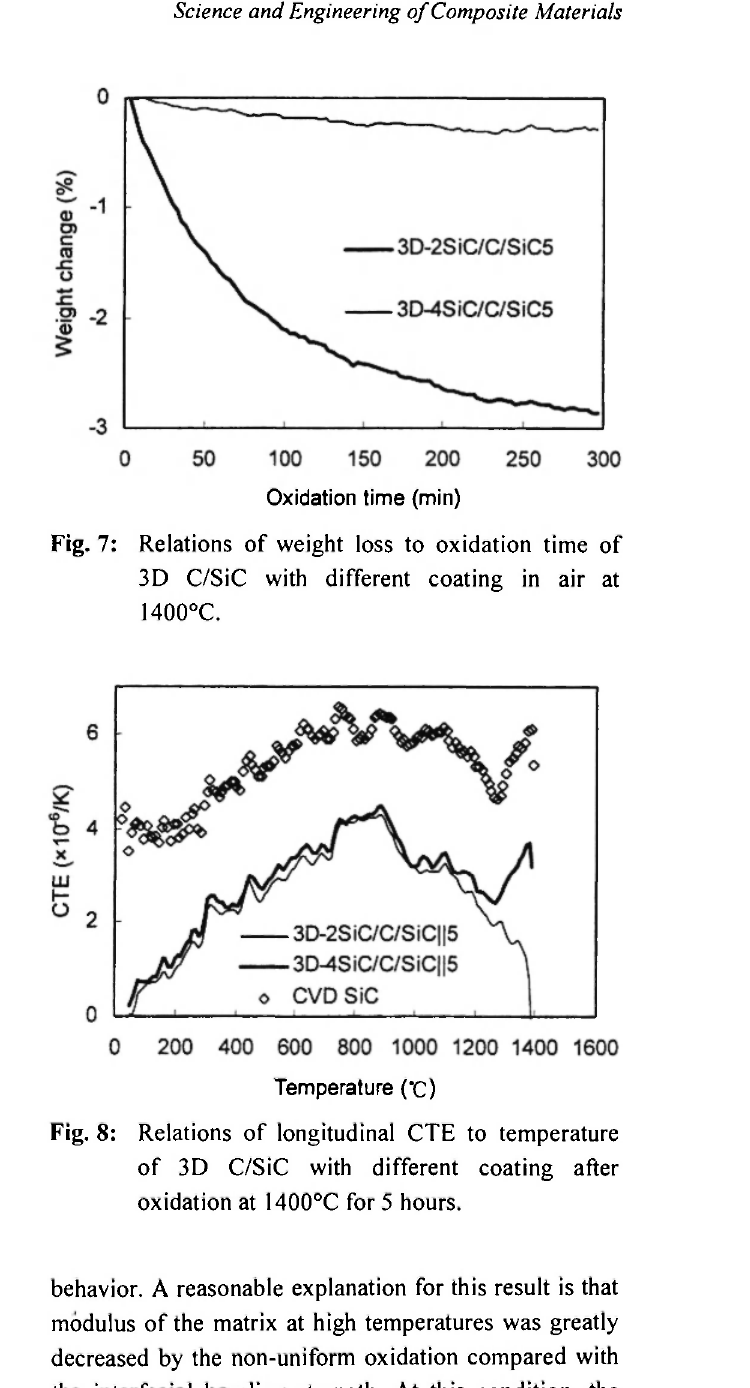
Fig. 8: Relations of longitudinal CTE to temperature of 3D C/SiC with different coating after oxidation at 1400°C for 5